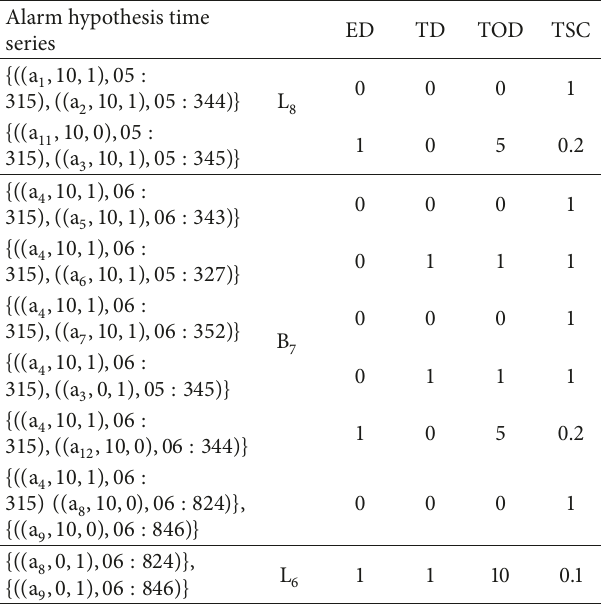
Table 11: The calculation of time series